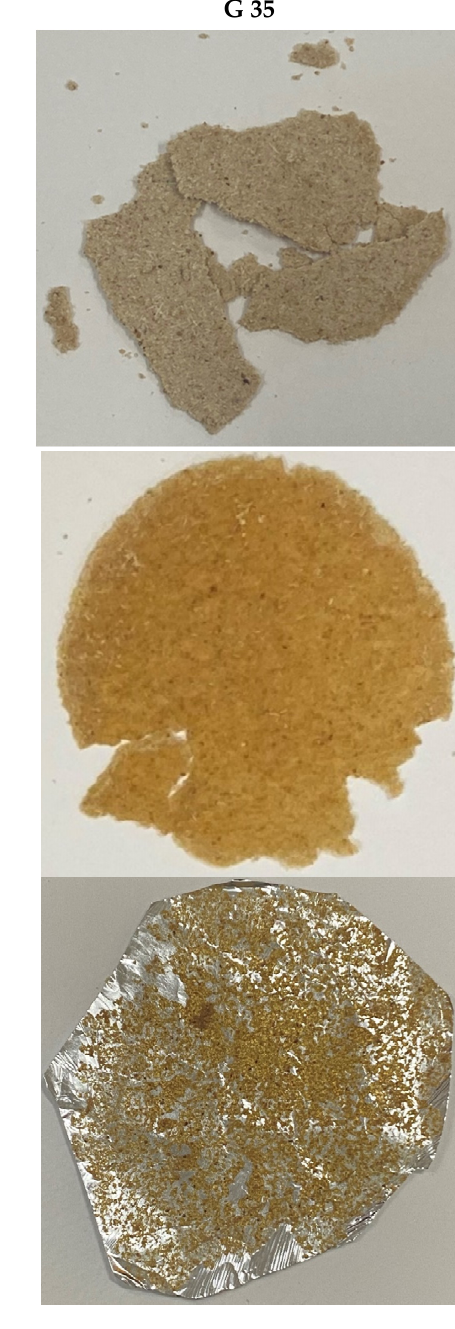
Figure 1. Macroscopic views of hot-pressed films prepared using G 30 (30% glycerol) and G 35 (35% glycerol) film-forming mixtures with ( a ) 60 °C, ( b ) 100 °C and ( c ) 140 °C temperature levels at 0.28 t pressure level.